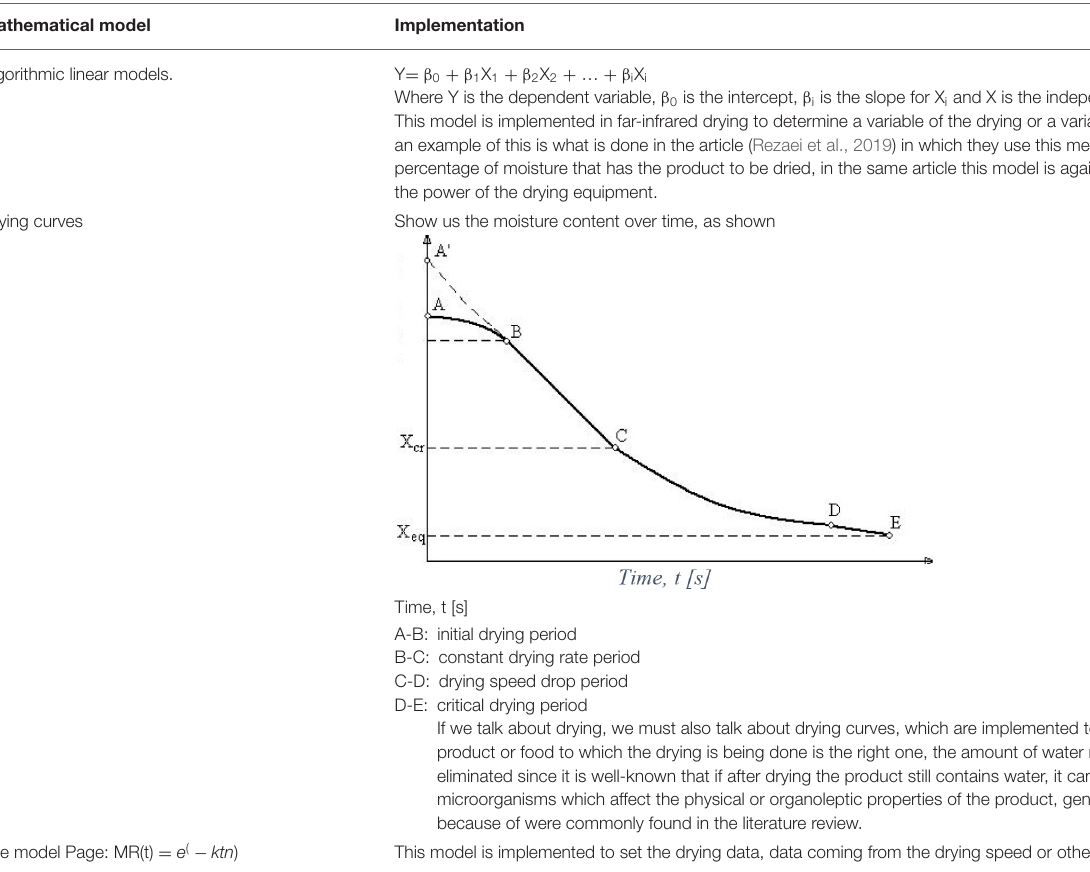
TABLE 2 | Identification of mathematical models worked by the different authors. Mathematical model Implementation Algorithmic linear